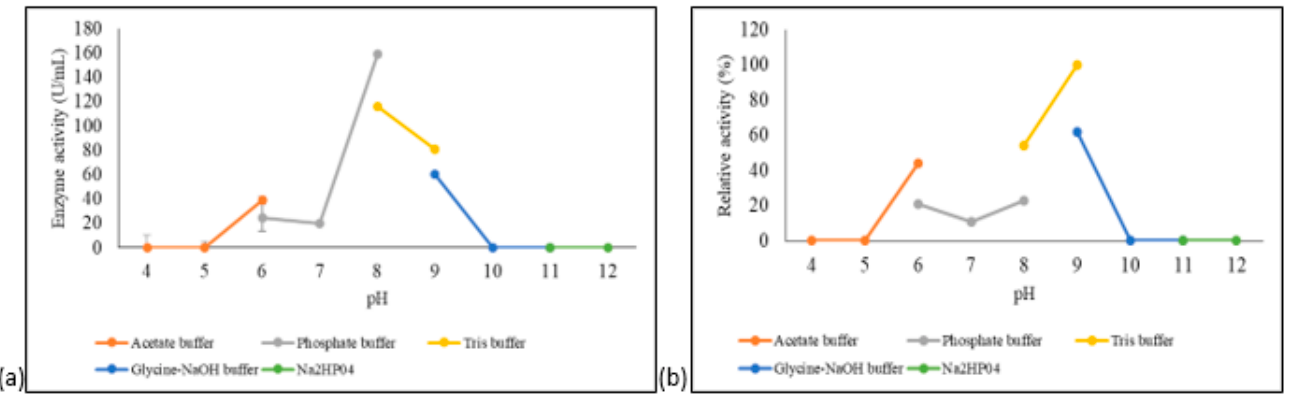
Figure 6. pH optimum and stability of the purified A. geothermalis ALDH. ( a ) Effect of pH on the activity of aldehyde dehydrogenase. ( b ) Effect of pH on the stability of aldehyde dehydrogenase. The pH stability profile of A. geothermalis ALDH is shown in Figure 6b. A. geothermalis ALDH is most stable in Tris-HCl pH 9 compared to Tris-HCl, pH 8. The activity of A. geothermalis ALDH was reduced to less than 50% at pH 6–8.